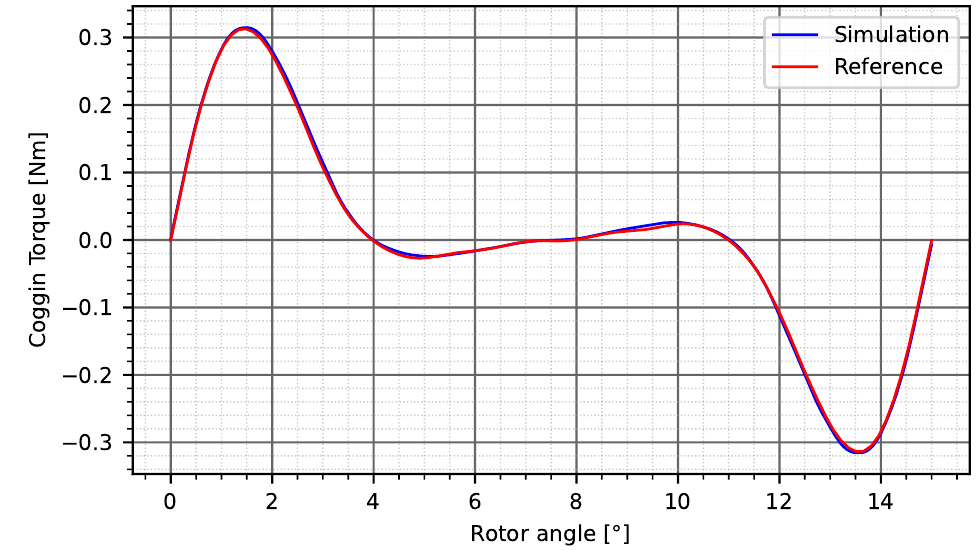
Figure 7. Comparison of the simulated and the reference cogging torque.